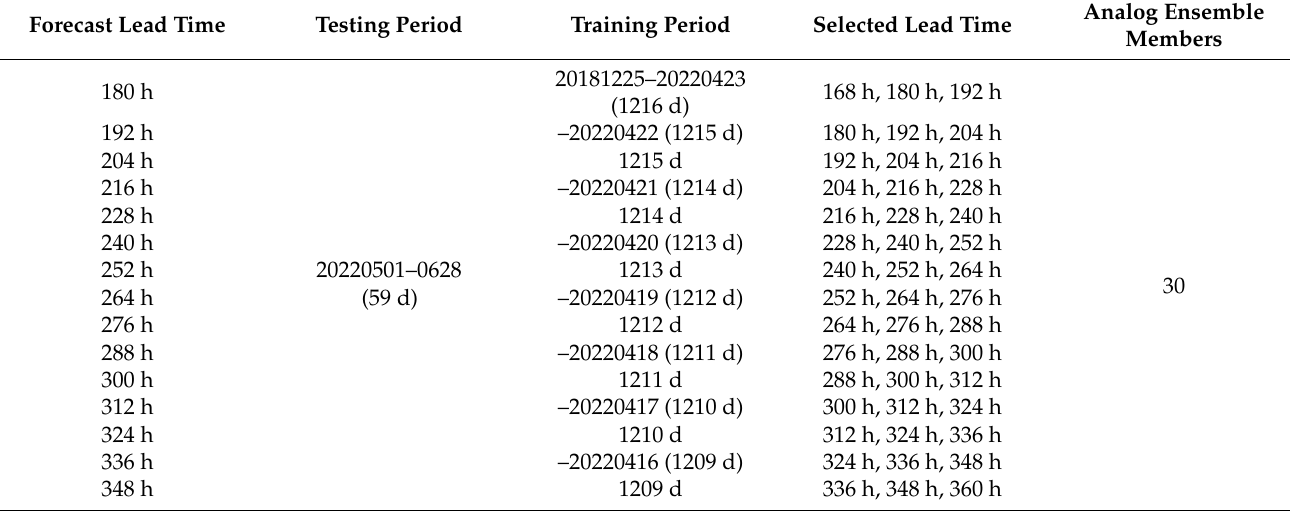
Table 1. Data duration and parameter setting for each forecast